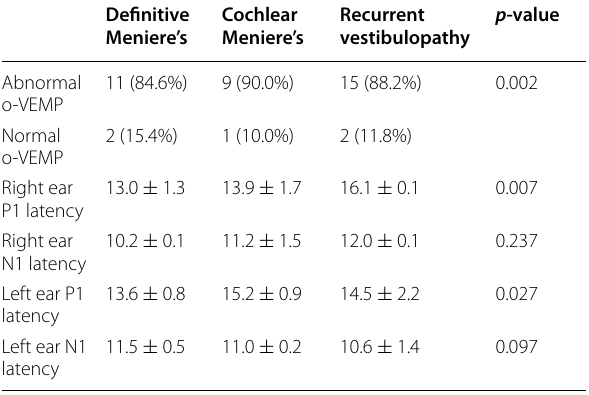
Table 14 o-VEMP P1 and N1 latencies and abnormalities in the left and right ear